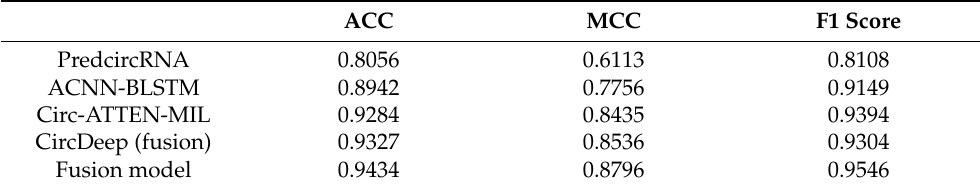
Table 2. The comparison results.